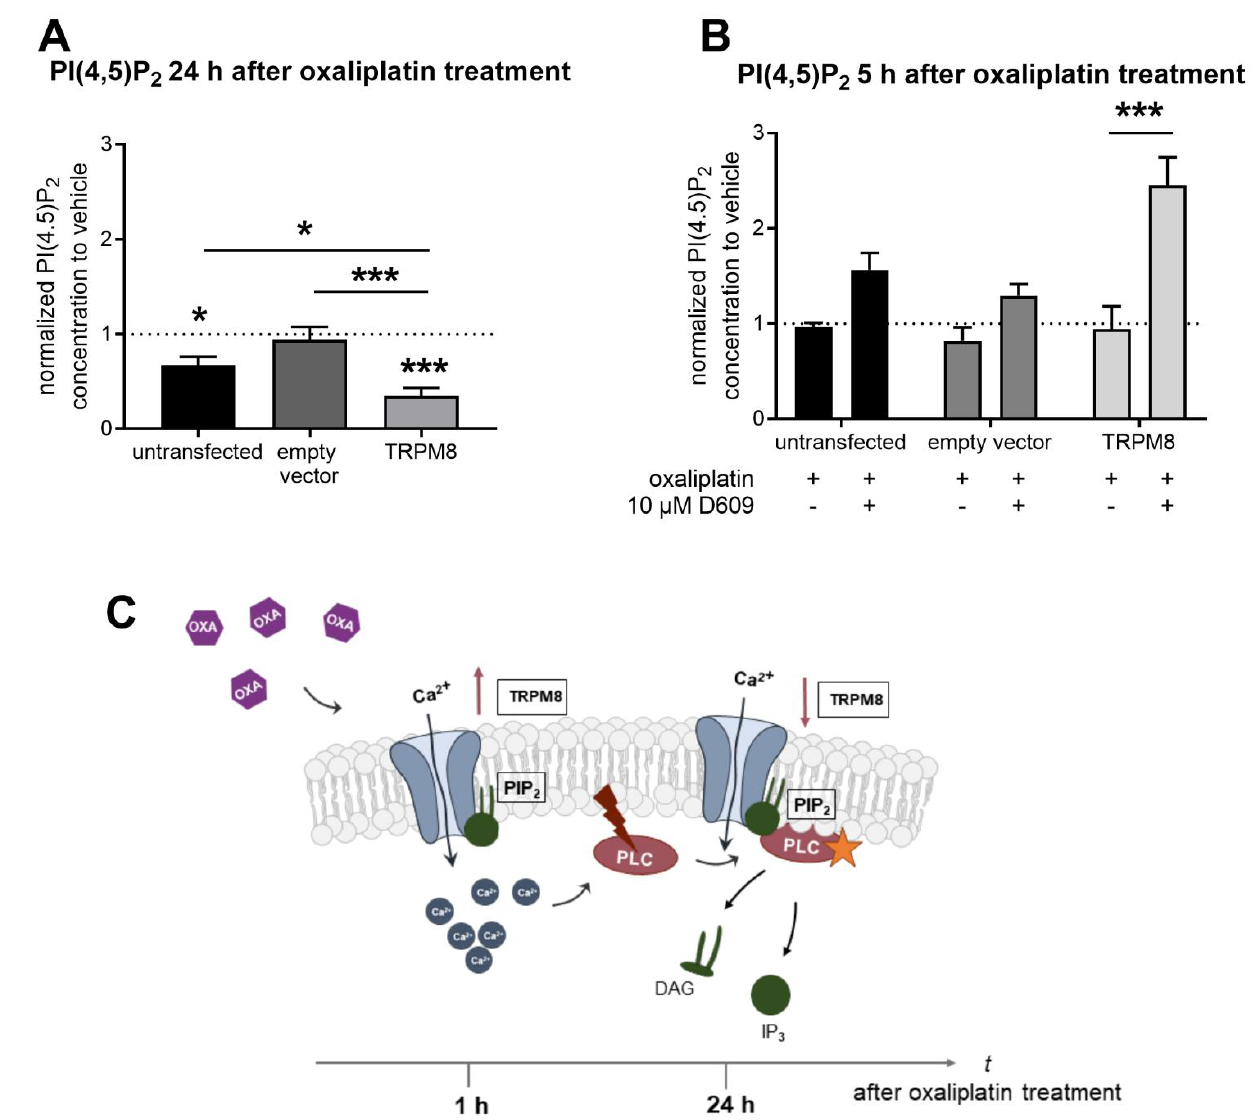
Figure 4. Phosphatidyl 4,5-bisphosphate concentrations are altered after oxaliplatin treatment. ( A ) Relative PIP 2 (phosphatidylinositol 4,5-bisphosphate) concentrations of untransfected HEK cells, empty-vector-transfected and TRPM8-transfected HEK cells treated with vehicle (saline) or 10 µM oxaliplatin for 24 h. Data represent the means ± SEM from n = 10 – 12 dishes per condition. * p < 0.05; *** p < 0.001; one-way ANOVA and Dunnett´s multiple comparison test. ( B ) Relative PIP 2 concentrations of untransfected HEK cells, empty-vector-transfected and TRPM8-transfected HEK cells that were treated with vehicle (saline), 10 µM oxaliplatin ±10 µM of the PLC inhibitor D609 for 5 h. Data represent the means ± SEM from n = 4 – 6 dishes per condition. *** p < 0.001; one-way ANOVA and Dunnett´s multiple comparison test. ( C ) Schematic overview of the proposed mechanisms leading to TRPM8 channel desensitization after acute oxaliplatin treatment. TRPM8 channel activation causes PLC pathway activation. In turn, PLC hydrolyzes PIP 2 to IP 3 (inositol 1,4,5-triphosphate) and DAG (1,2-diacylglycerol). PIP 2 -depletion is responsible for TRPM8 channel desensitization after oxaliplatin treatment.